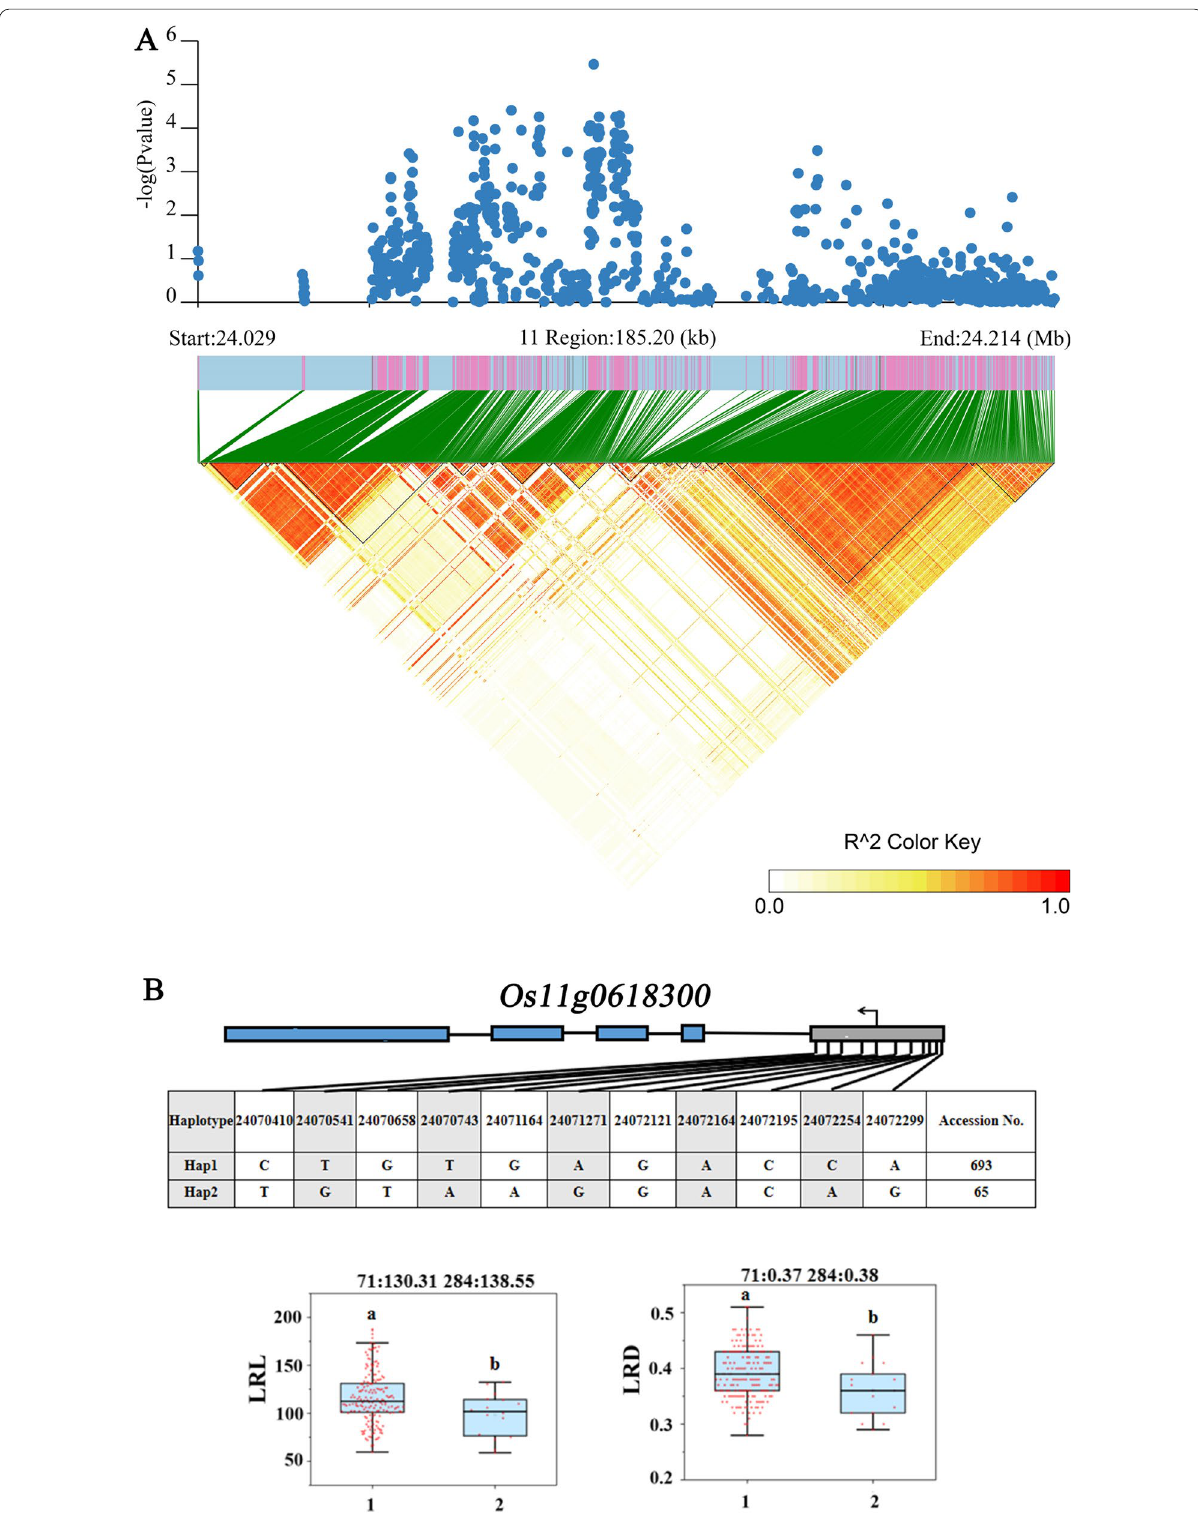
Fig. 9 Associated region and haplotype analysis of Os11g0618300 . A Regional Manhattan plots and LD heatmap of Os11g0618300 . B Gene structure and haplotype analysis of Os11g0618300 . LRD: root diameter under low-nitrogen treatment. LRL: root length under low-nitrogen